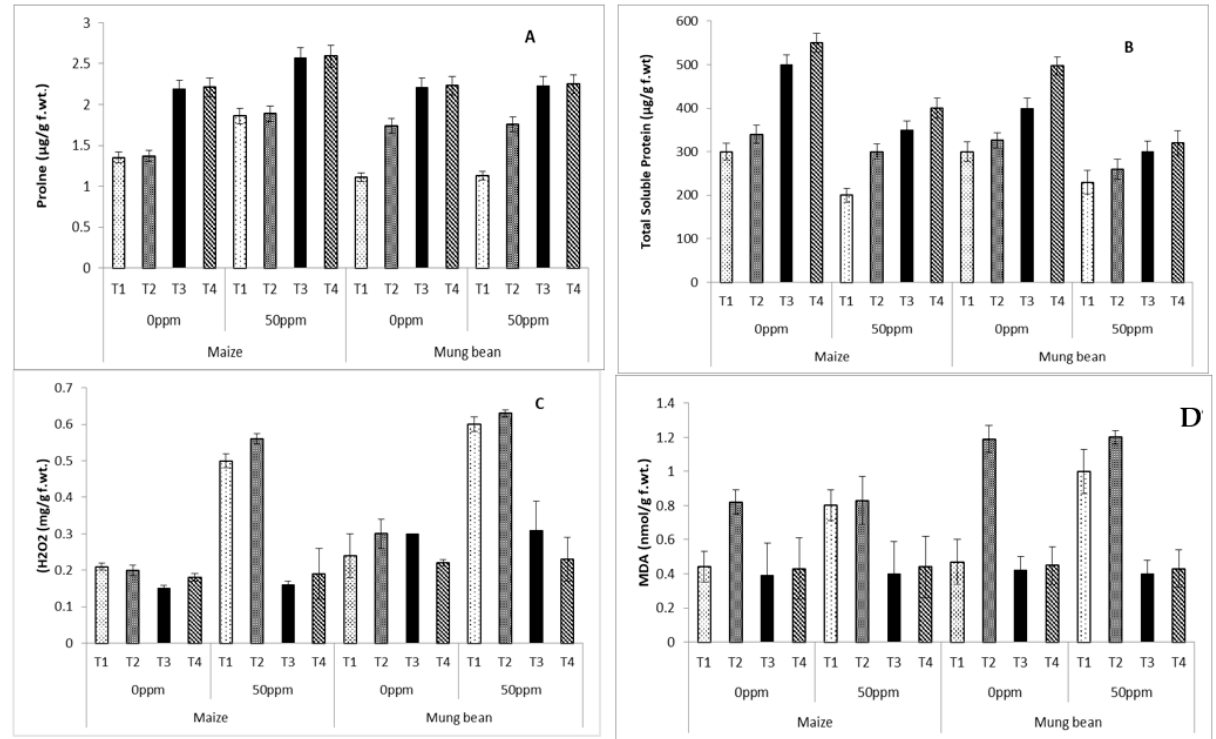
Figure 4. Biochemical attributes ( A ) Proline ( B ) Total soluble proteins ( C ) H 2 O 2 ( D ) MDA of maize ( Zea mays L.) and mung bean ( Vigna radiata L.) exogenously treated with B. subtilis strains under chromium stress (0 ppm vs. 50 ppm) conditions (mean ± S.E.). Here, T1 = Nutrient broth, T2 = Nutrient broth + parent B. subtilis , T3 = Nutrient broth + UV ‐ irradiated B. subtilis and T4 = Nutrient broth + γ ‐ irradiated B. subtilis .